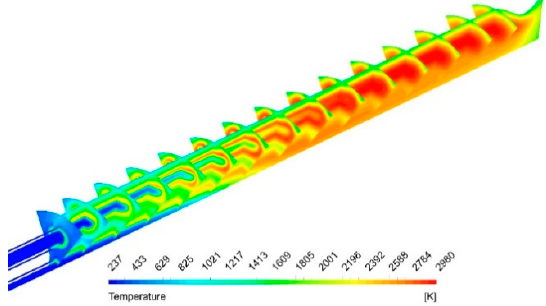
Figure 11. The no-radiating temperature field (50% axial scaling).